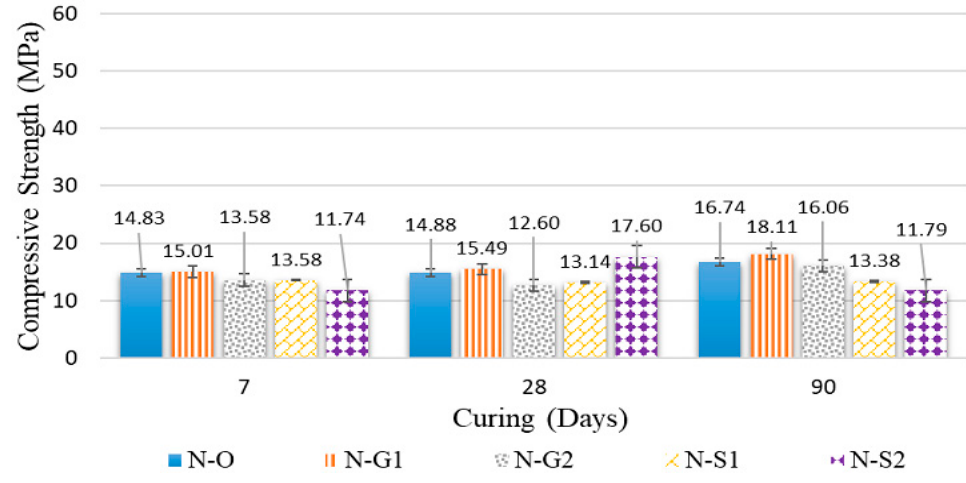
Figure 4. Compressive strength results for ordinary-strength pervious concrete specimens.